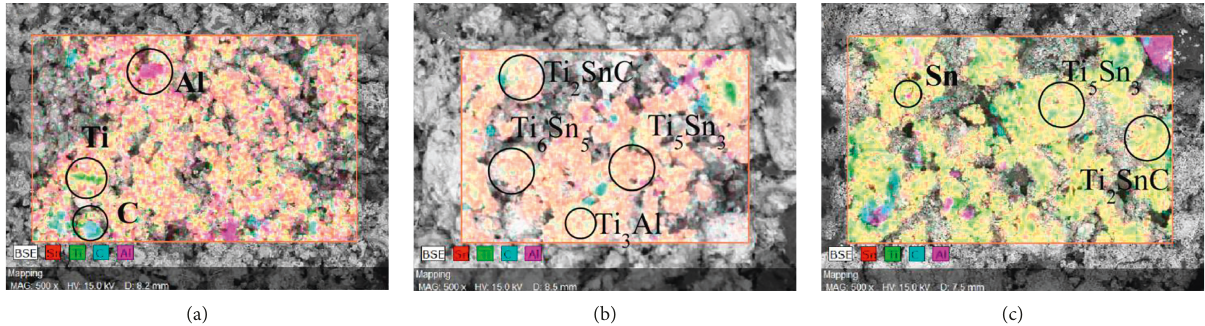
Figure 10: EDS micrographs of Ti 2 SnC with ratio Ti :Sn :Al :C (cid:31) 2 :1: 0.2:1 at (a) 800 ° C, (b) 1000 ° C, and (c) 1200 ° C.